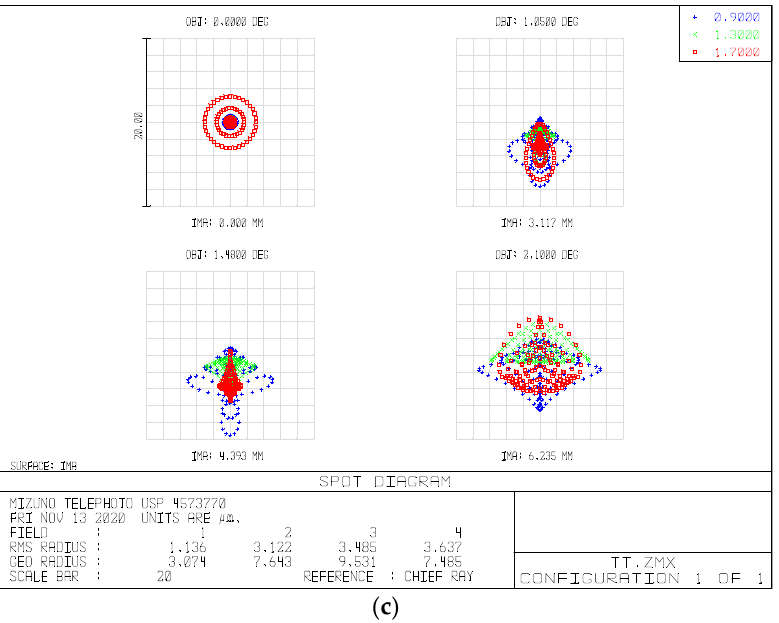
Figure 6. Optical performances of the fore-optics: ( a ) modulation transform function (MTF) of the system, ( b ) spot diagram, and ( c ) field curvatures and distortions of the different wavelengths.